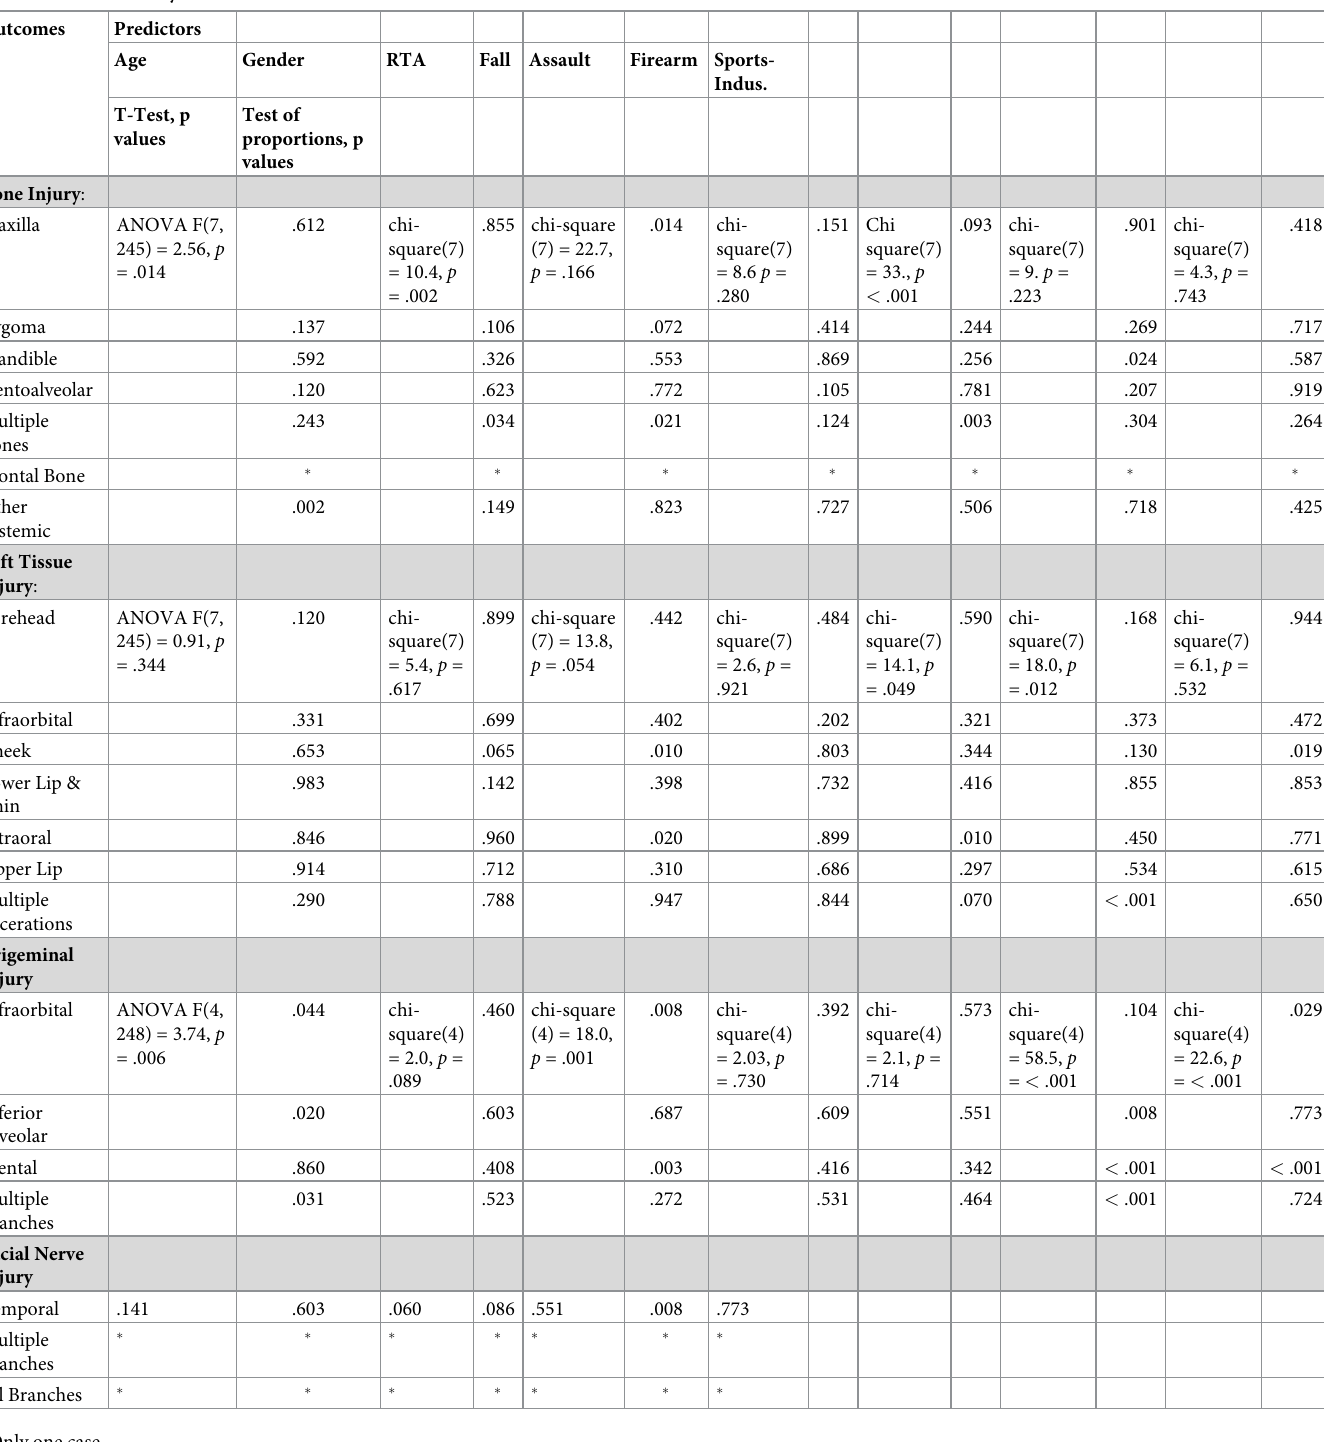
Table 2. Bivariate